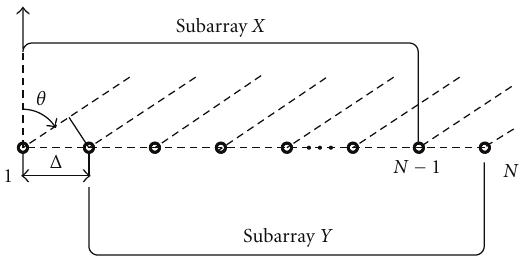
Figure 3: A structure of a radar signal used in the MTD